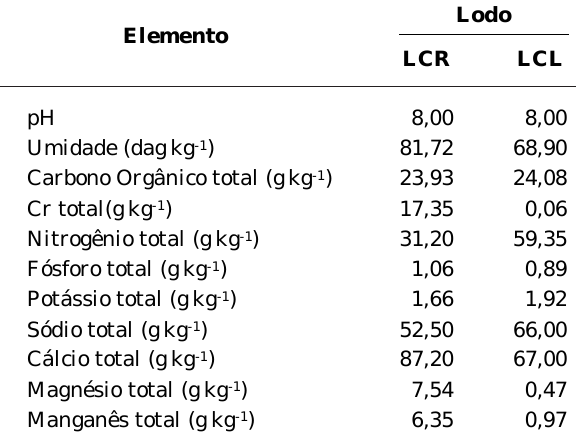
(a) LVA vs LRe e isoladamente para cada um dos solos; (b) testemunha vs demais; (c) testemunha